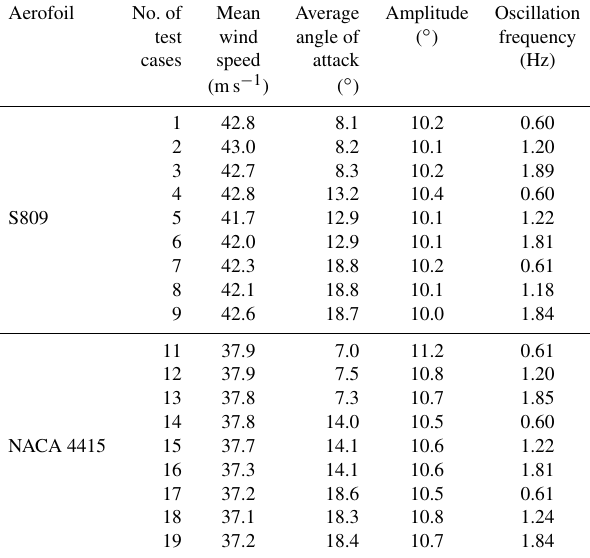
Table 1. Selected cases from the OSU